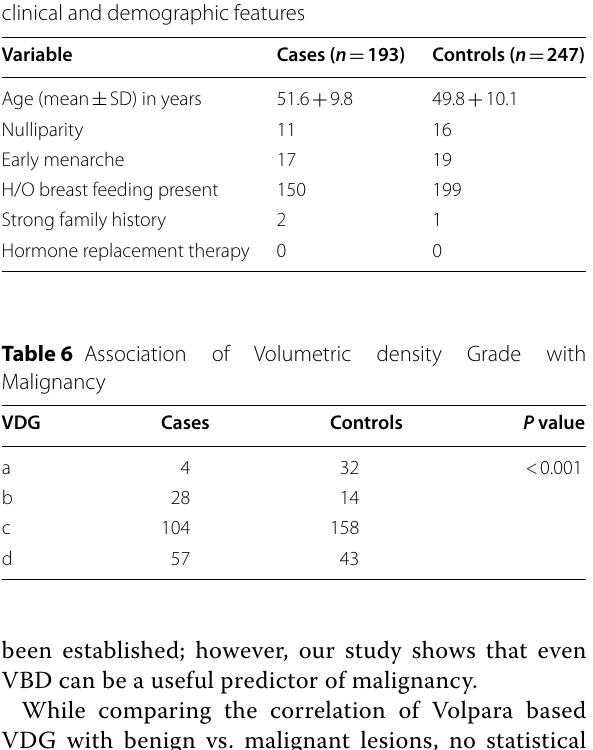
Table 7 Results of Bonferroni